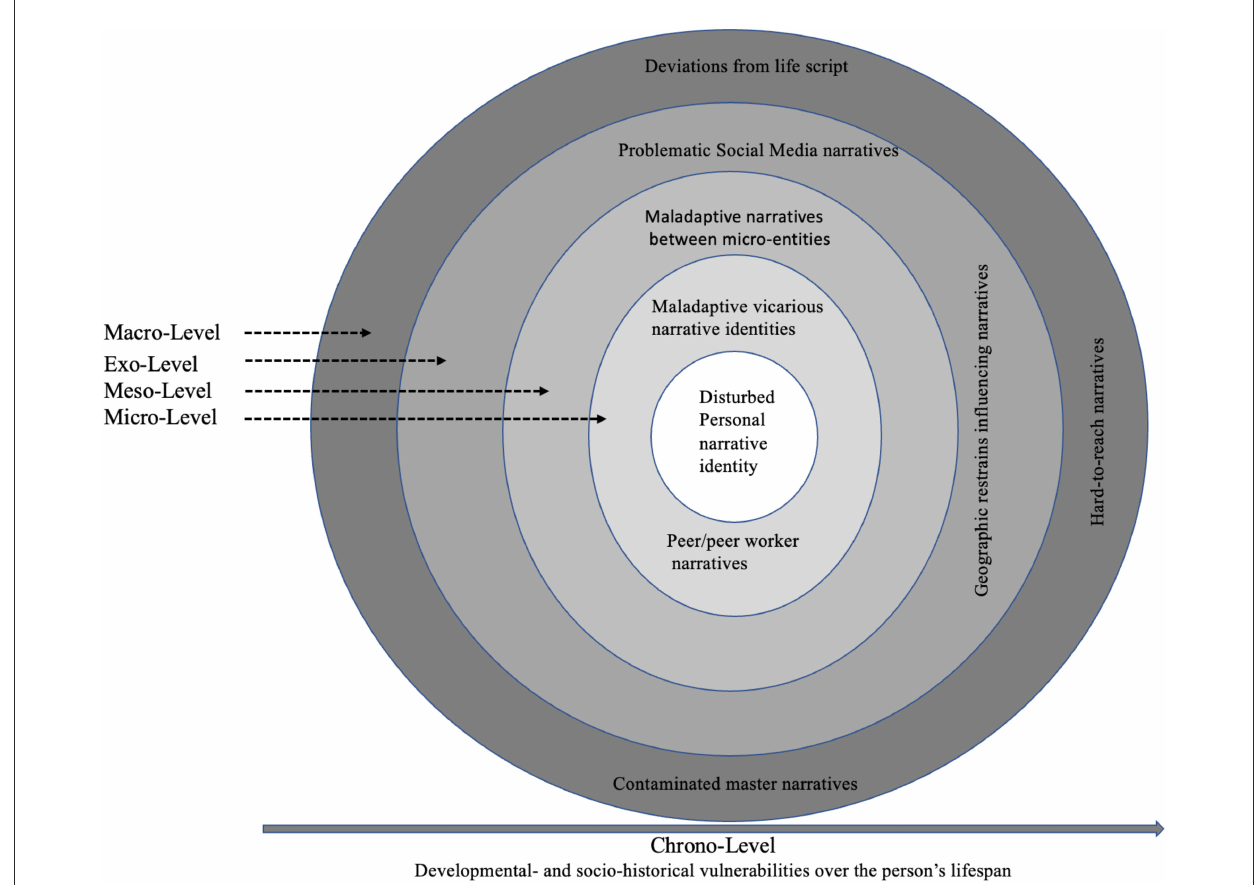
FIGURE1 Visual illustration of the maladaptive narrative ecology in people manifesting